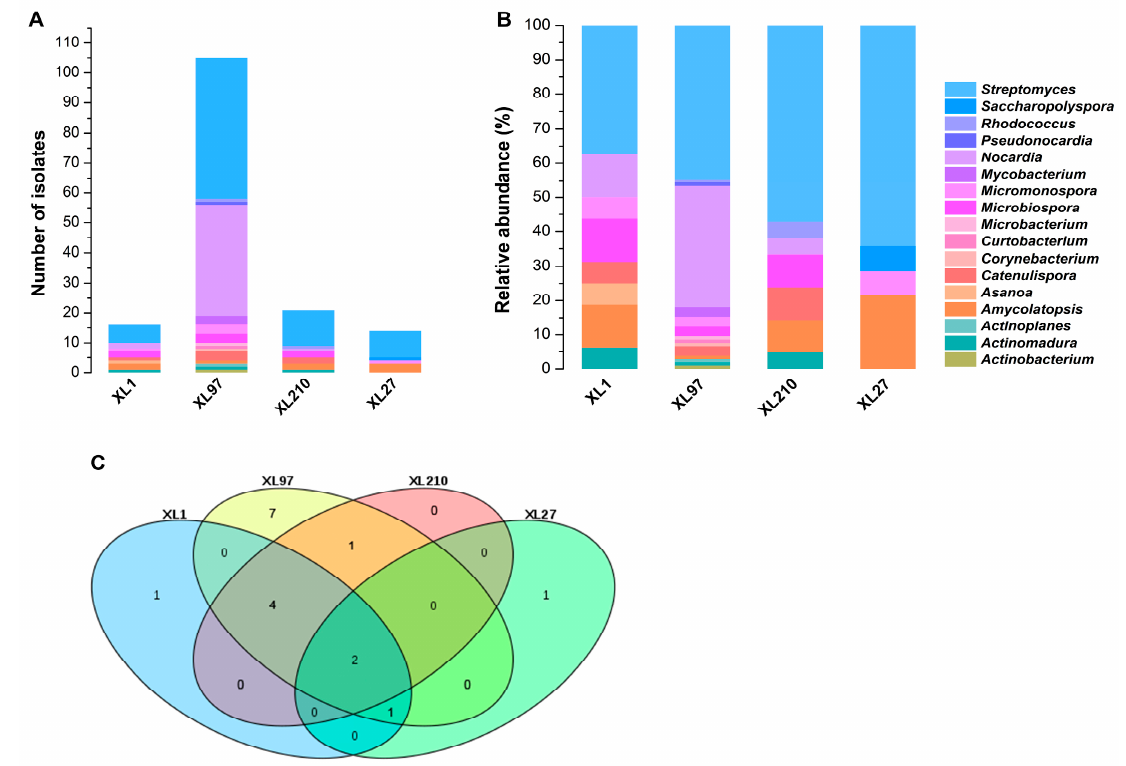
Figure 2. Culturable composition of endophytic actinobacteria in C. oleifera samples showing number ( A ) and relative abundance ( B ) at the genus level, and exclusive and shared numbers of genera ( C ) among four C. oleifera samples.